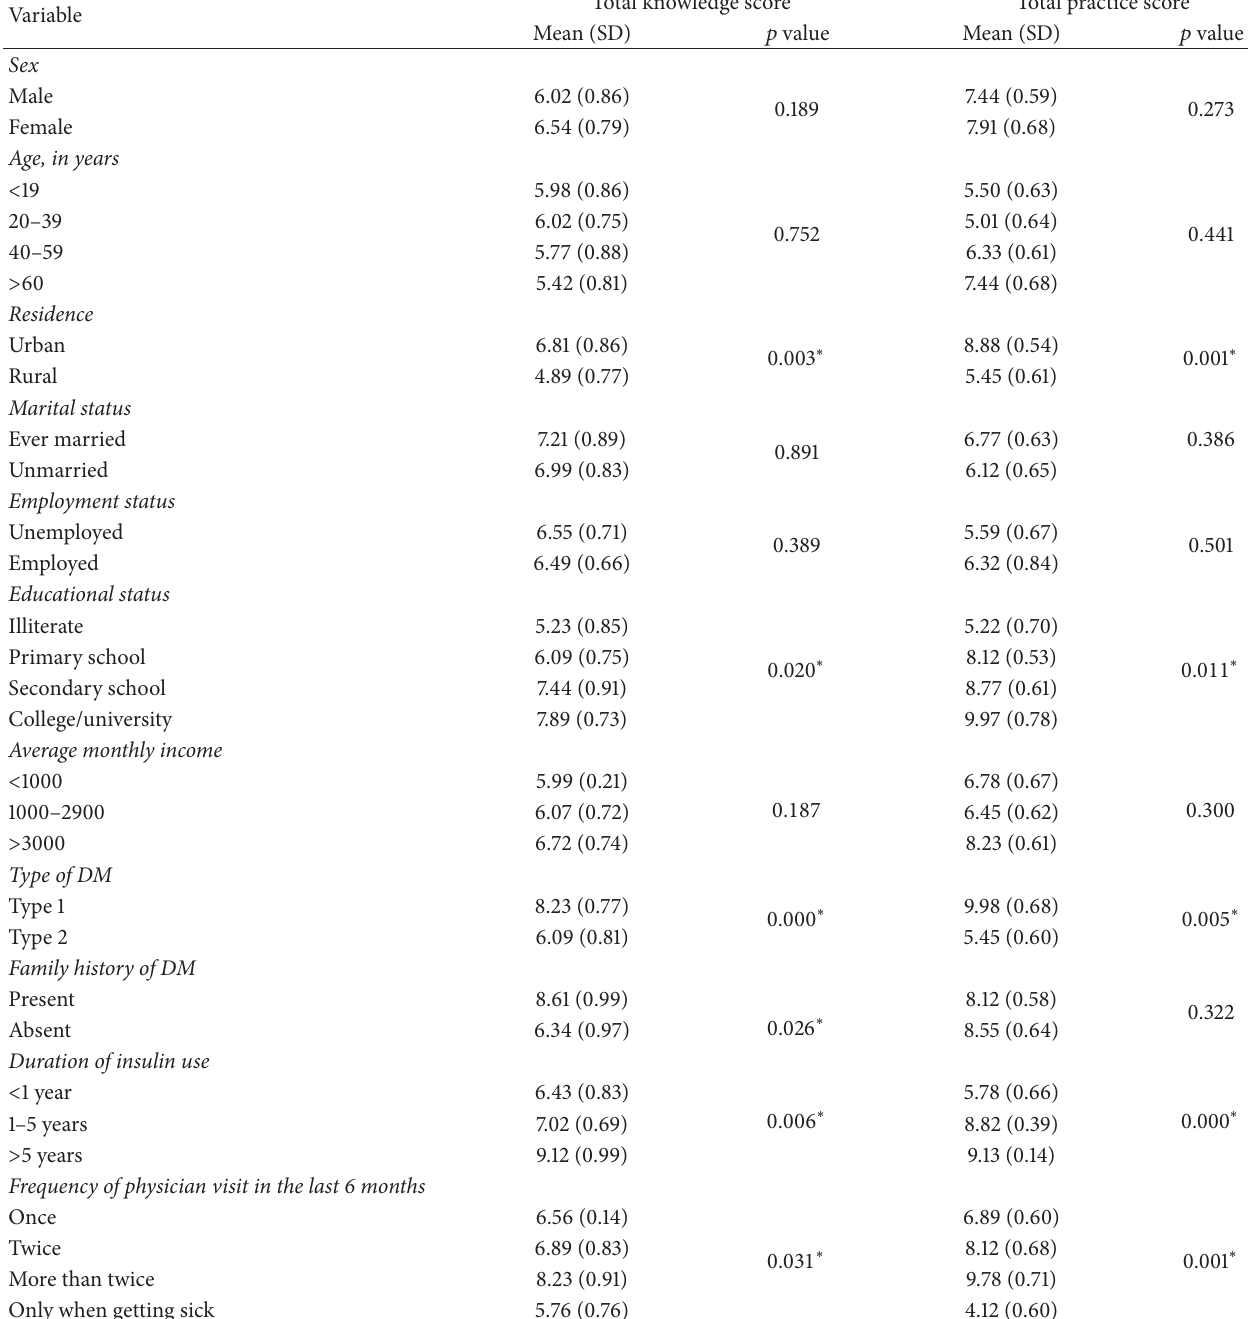
Table 5: Mean knowledge and practice scores of respondents according to different characteristics ( 𝑛 = 210